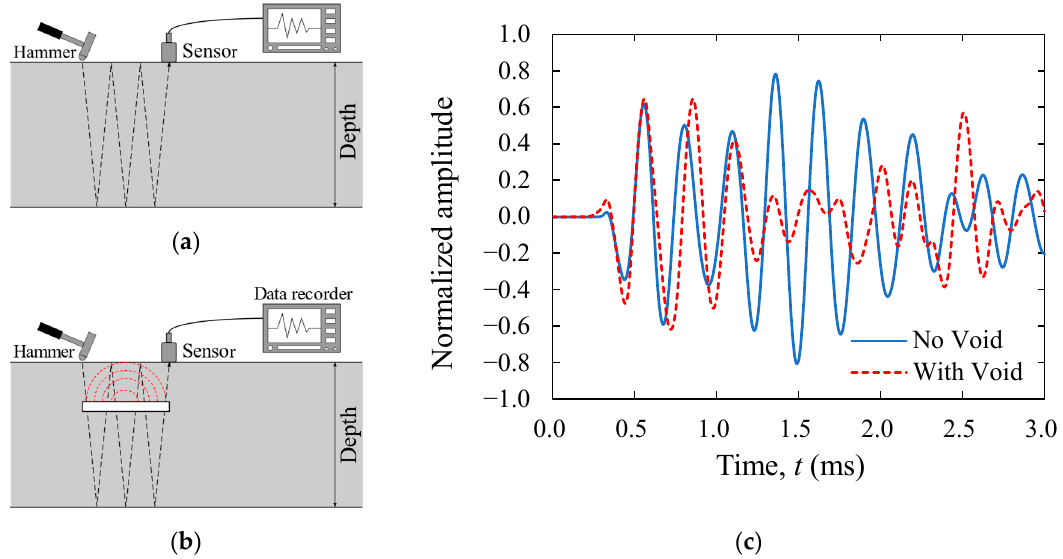
Figure 6. Concept of Difference value Analysis in Time Domain: ( a ) No void; ( b ) With void; ( c ) Example of response waveform comparison.